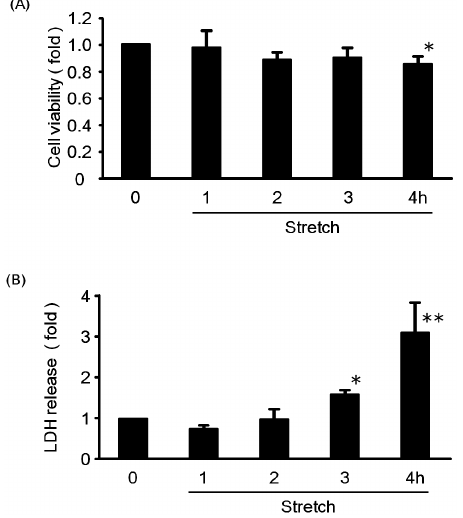
Figure 1. Time course for the effects of cyclic mechanical stretch (15% elongation) on cell viability (A) and cell death (B) in RASMCs up to 4 h. The cells cultured under standard conditions were exposed to cyclic mechanical stretch by 15% elongation for various time periods (from 1 to 4 h) and then incubated for 24 h. Cell viability and cell death were evaluated by MTT assay and the release of lactate dehydrogenase (LDH), respectively. Colorimetric analysis of each value was normalized by arbitrarily setting the absorbance value of the control cells (Ctrl.) to 1. Each value represents the mean 6 standard deviatin (S.D.) (n=4). The asterisks represent significant differences compared with the control value (* P , 0.05).